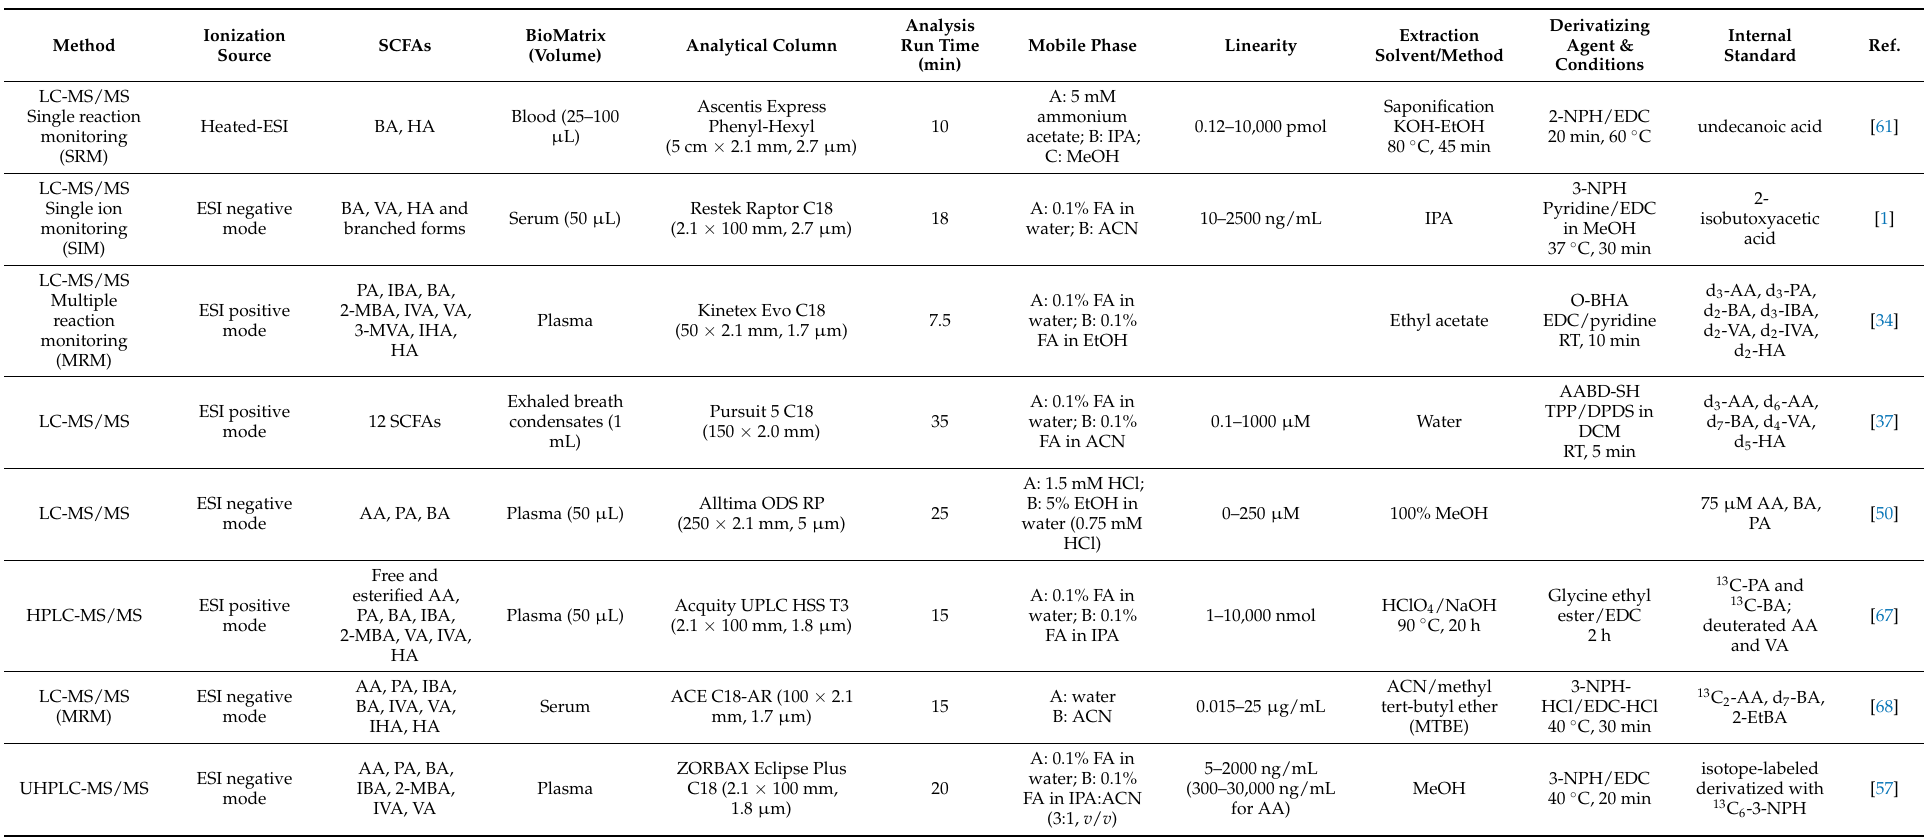
Table 1. SCFAs quantified in human blood, plasma, and